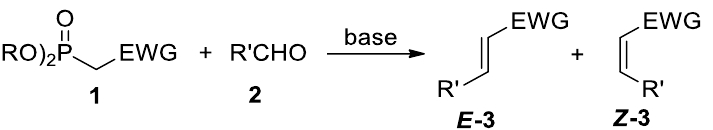
Scheme 1. General scheme of the Horner–Wadsworth–Emmons